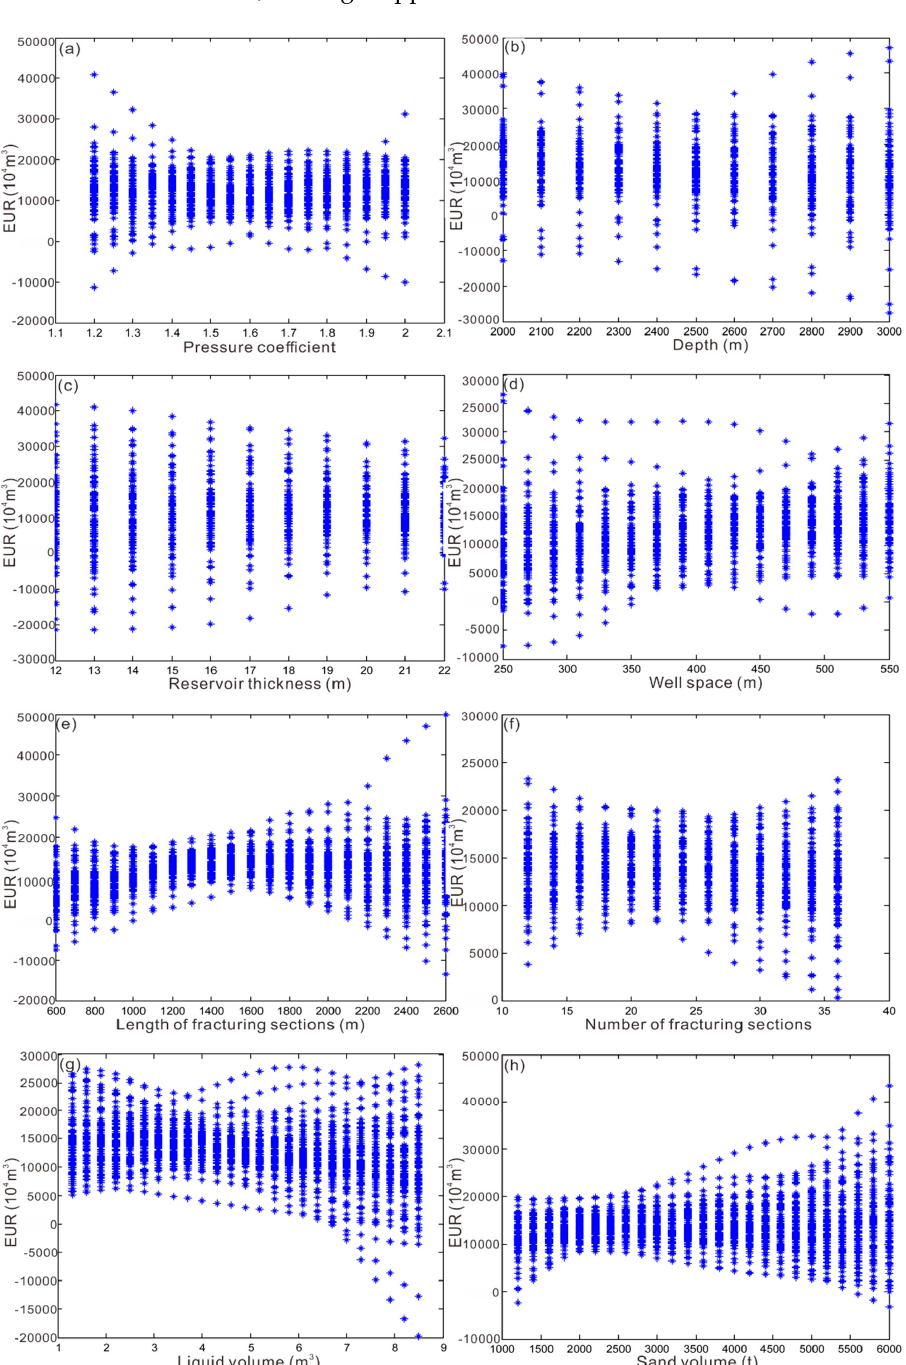
Figure 4. Fitted results of 200 times of random BP neural network for a standard well in Changning block. ( a ) Relationship between EUR and pressure coefficient; ( b ) relationship between EUR and depth; ( c ) relationship between EUR and reservoir thickness; ( d ) Relationship between EUR and number of well space; ( e ) relationship between EUR and length of fracturing sections; ( f ) relationship between EUR and number of fracturing sections; ( g ) relationship between EUR and liquid volume; ( h ) relationship between EUR and sand